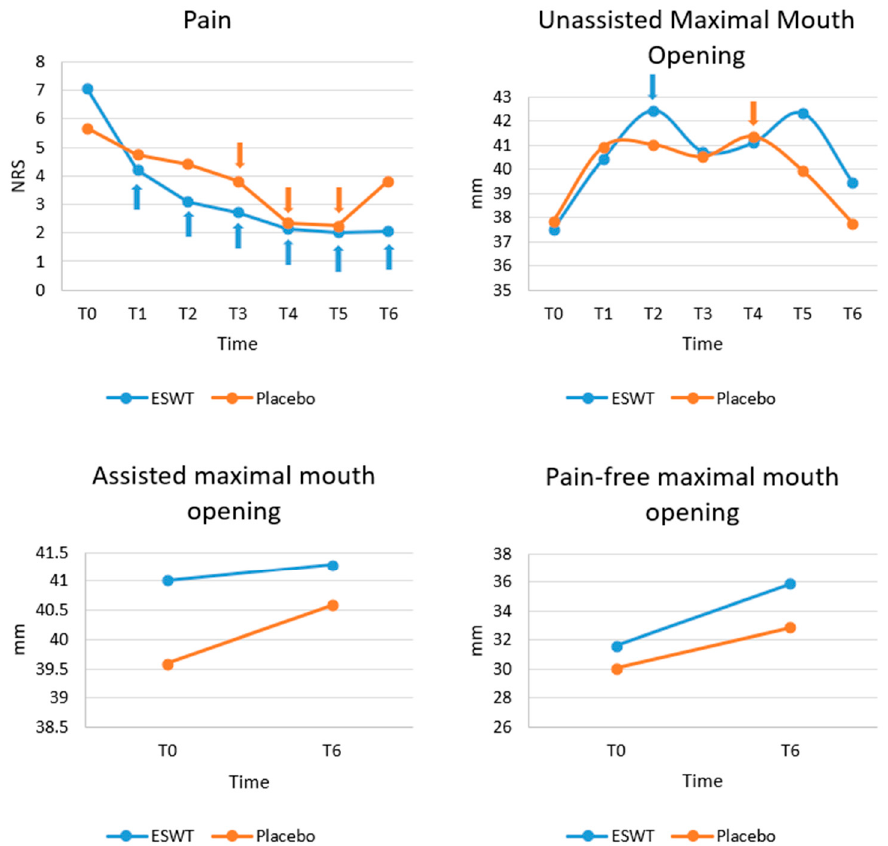
Figure 2. Progression of clinical variables (pain, unassisted maximum mouth opening, assisted maximum mouth opening, pain-free mouth opening) at different time points. Although greater reduction in pain and increase in mouth opening was seen in Group 1, there was no statistically significant difference of any variables at any time point between the two groups. For within group analyses, those values with significant difference compared to baseline (T0) are marked with arrows with corresponding colours. NRS, numerical rating scale; MO, mouth opening; T0, baseline; T1, 1 week after the first session; T2, 2 weeks after the first session; T3, 3 weeks after the first session; T4, 6 weeks after the first session; T5, post ‐ treatment 3 months; T6, post ‐ treatment 1 year.